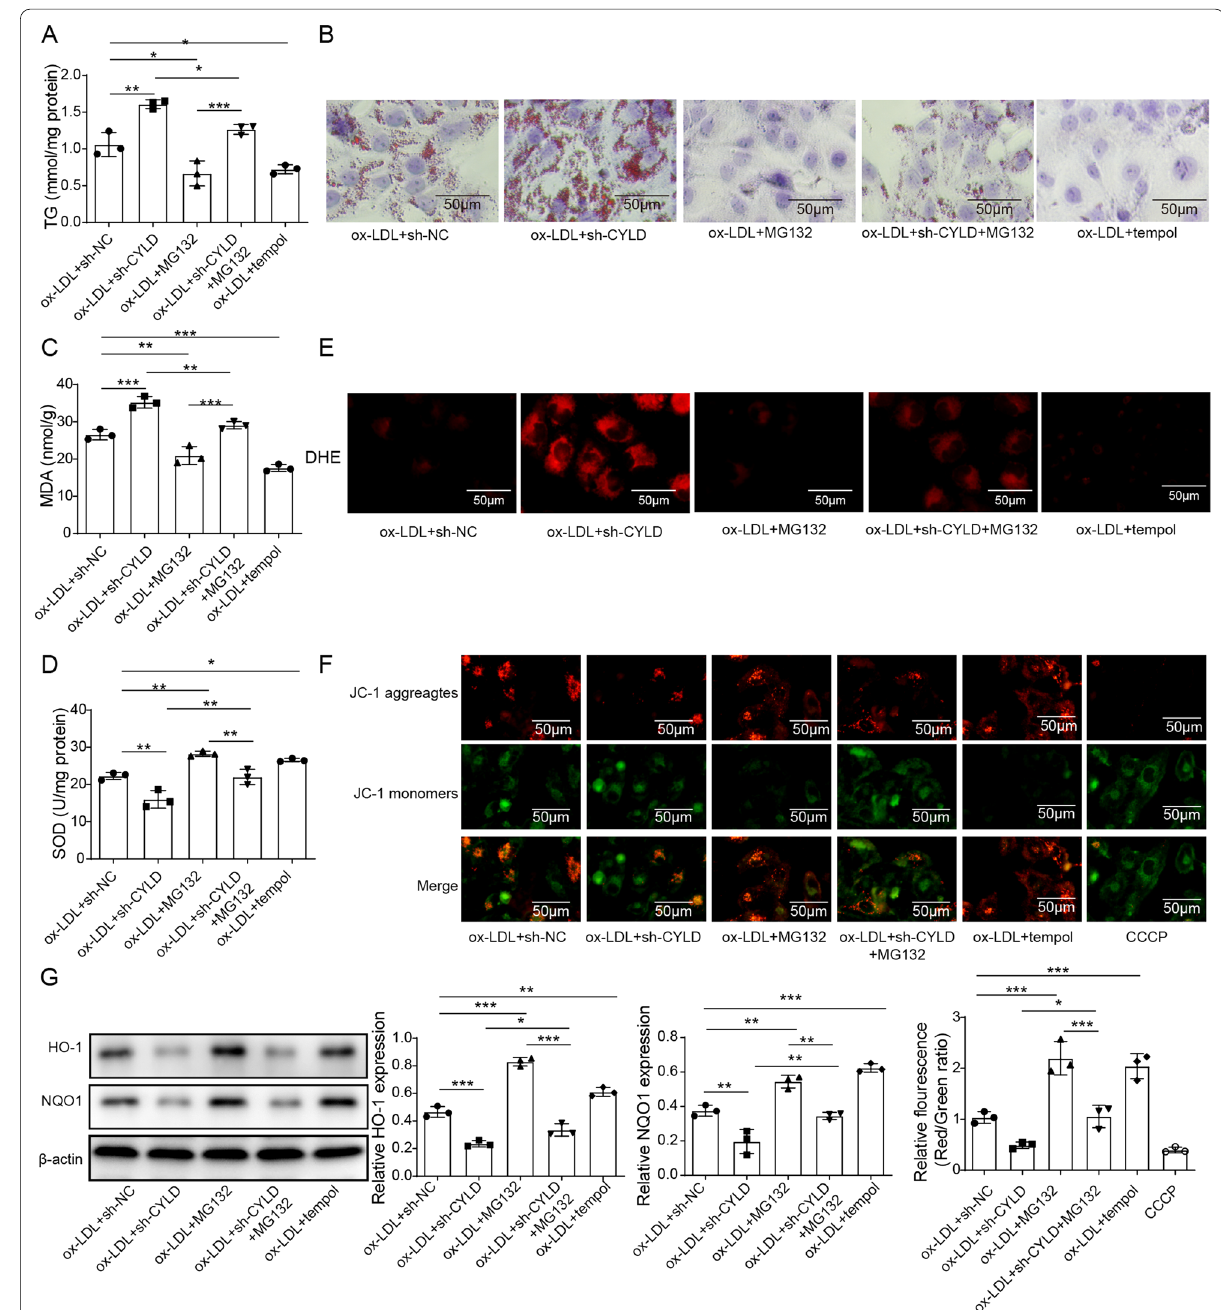
Fig. 7 MG132 inhibited the promoting effect of CYLD knockdown on oxidative stress in ORN cells. The proteasome inhibitor MG132 was used to regulate the expression of Nrf2. Cells were divided into five groups: ox‑LDL sh‑NC, ox‑LDL sh‑CYLD, ox‑LDL MG132, + + + ox‑LDL sh‑CYLD MG132 and ox‑LDL tempol. A – F The effect of MG132 on TG levels, lipid deposition, MDA levels, SOD activity, ROS levels + + + and ΔΨm. G The protein expression of HO‑1 and NQO1 was measured using western blotting. CYLD, cylindromatosis; ORN, obesity‑related nephropathy; Nrf2, NF‑E2‑related factor 2; ox‑LDL, oxidized low‑density lipoprotein; NC, normal control; MAD, malondialdehyde; SOD, superoxide dismutase; DHE, dihydroethidium; ROS, reactive oxygen species; ΔΨm, mitochondrial membrane potential; HO‑1, haem oxygenase 1; NQO1,